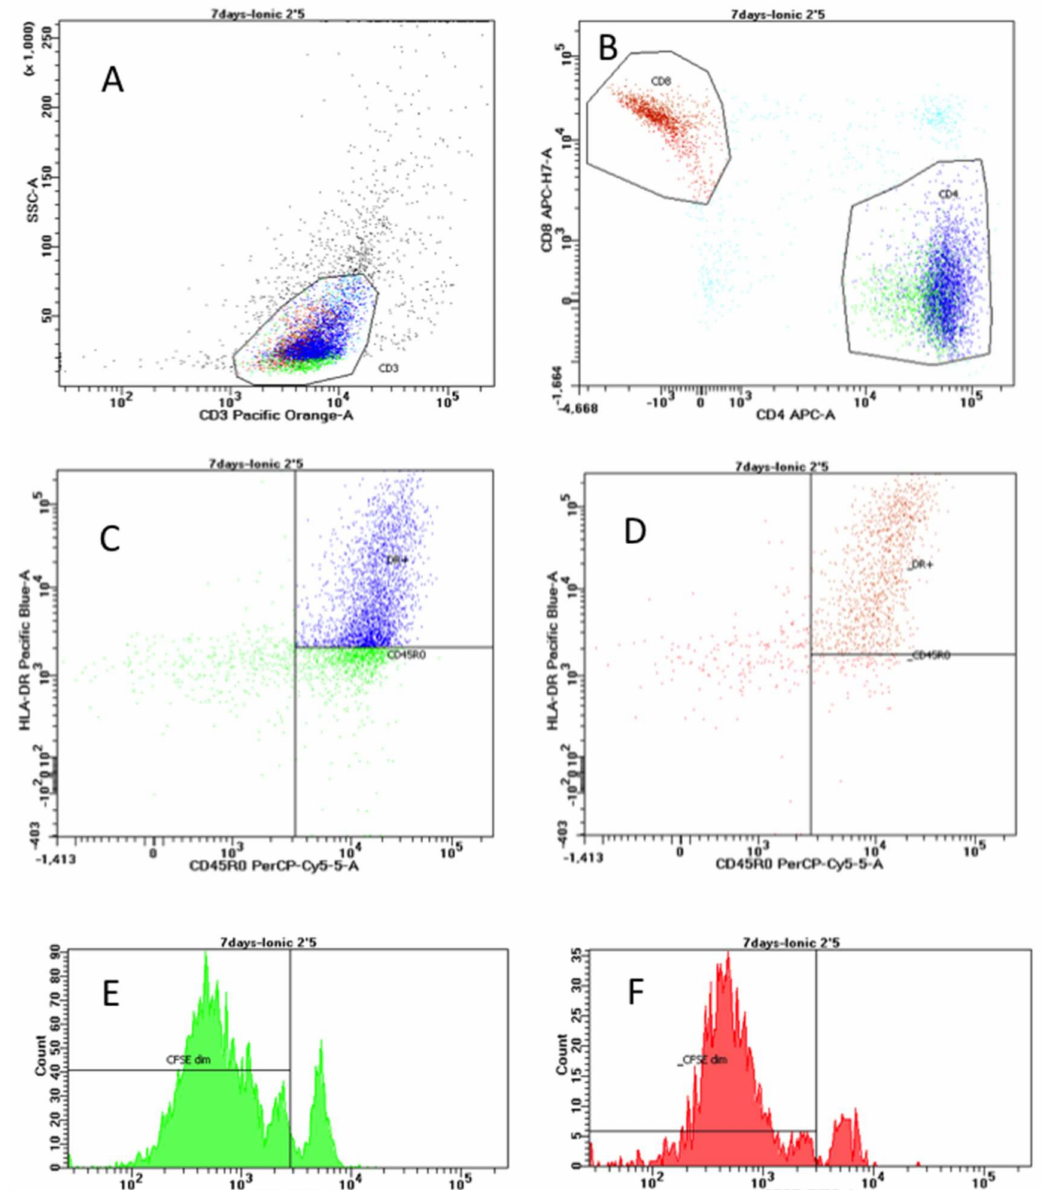
Figure A2. Flow chart example of the gating for the stimulated cell populations (2.5 ug/L ionic-Ti after seven days). ( A ) Gating on CD3+ lymphoid cells. ( B ) CD4+ cells (green), CD8+ cells (red). ( C ) Activated effector T helper cells (CD45RO+/HLA-DR+) in upper right quadrant. ( D ) Activated effector T cytotoxic cells (CD45RO+/HLA-DR+) in upper right quadrant. ( E ) CFSE-staining of CD4+ T cells showing cell division in several generations. ( F ) CFSE-staining of CD8+ T cells showing cell division in several